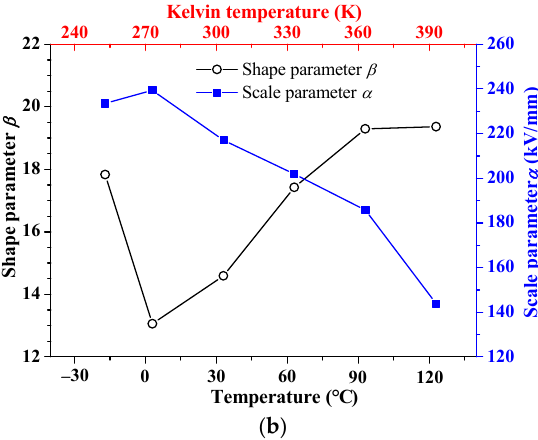
Figure 2. Temperature-dependent breakdown voltage of oil-impregnated paper insulation. ( a ) Weibull distribution of breakdown voltages; ( b ) Temperature-dependent shape and scale parameters.